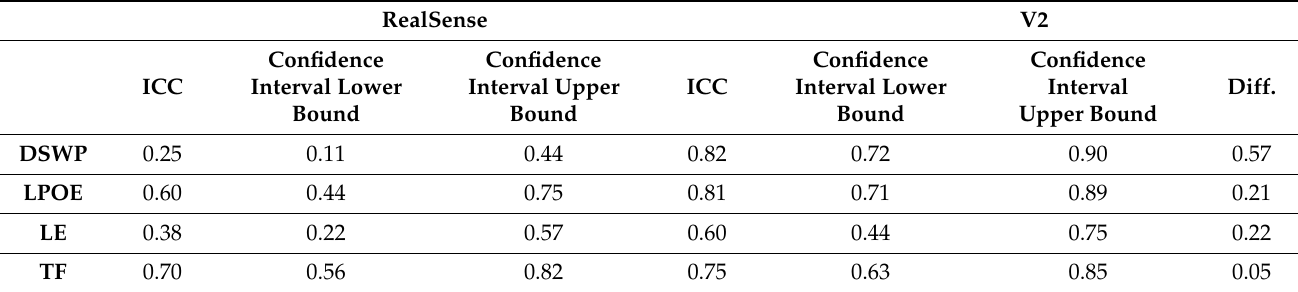
Table 3. Intra-rater reliability ICC 3,1 within RealSense and